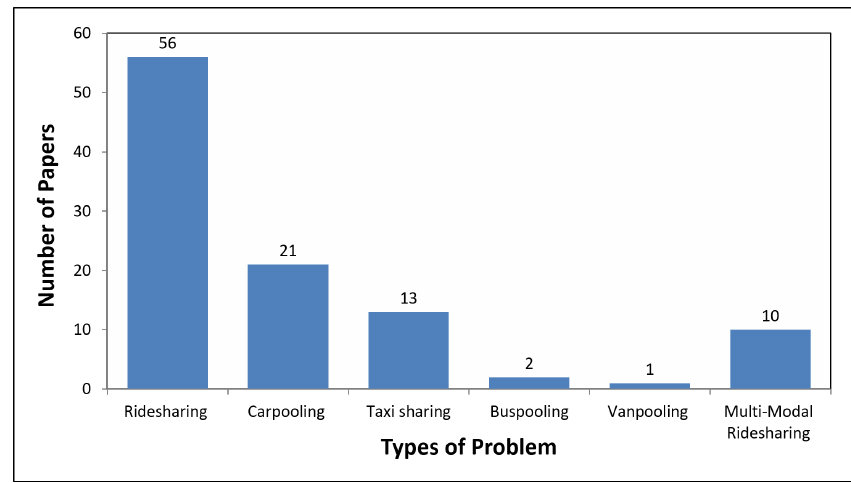
Figure 3. Number of Papers based on the Types of SMP.